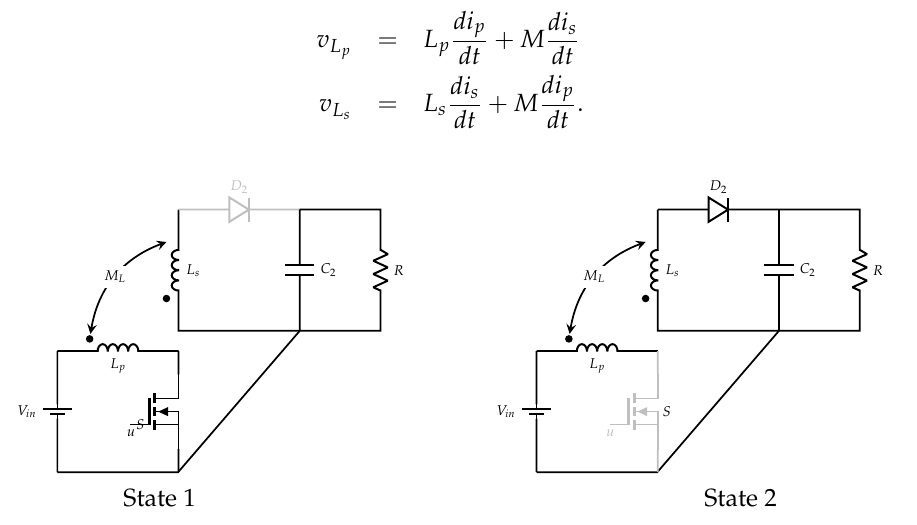
Figure A1. Flyback converter